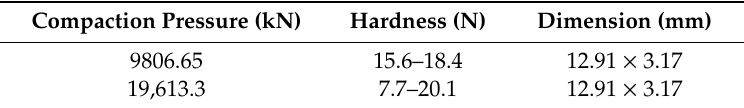
Table 4. Hardness of the F1 solid B-SNEDDS formulation. Hardness expressed as minimum and maximum values.